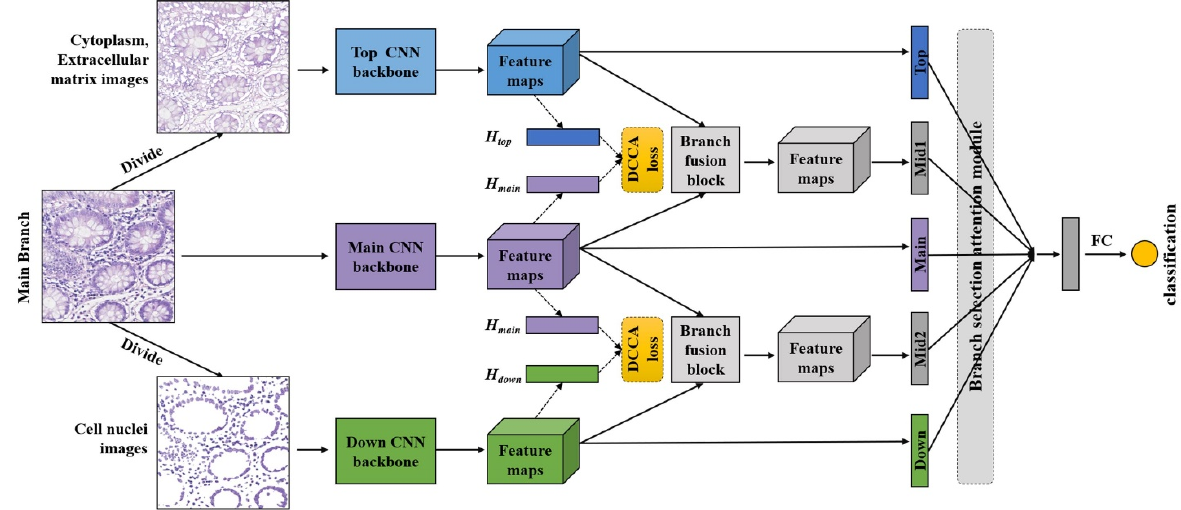
Figure 2. The overall network structure of the DANet. The proposed DANet has three inputs: the original pathological image (main branch), the nuclei image (down branch), and the non-nuclei image (top branch). Two middle branches are obtained through the branch fusion block and branch fusion attention (DCCA loss). After the independent feature extraction of a single branch and feature fusion of different branches, we use GAP to compress the feature maps obtained from the five branches into five feature vectors. Finally, the five feature vectors are passed through the branch selection attention module and the fully connected network to obtain the final classification result. The loss function for the DANet is defined as the combination of the cross-entropy loss and DCCA loss (indicated in yellow).